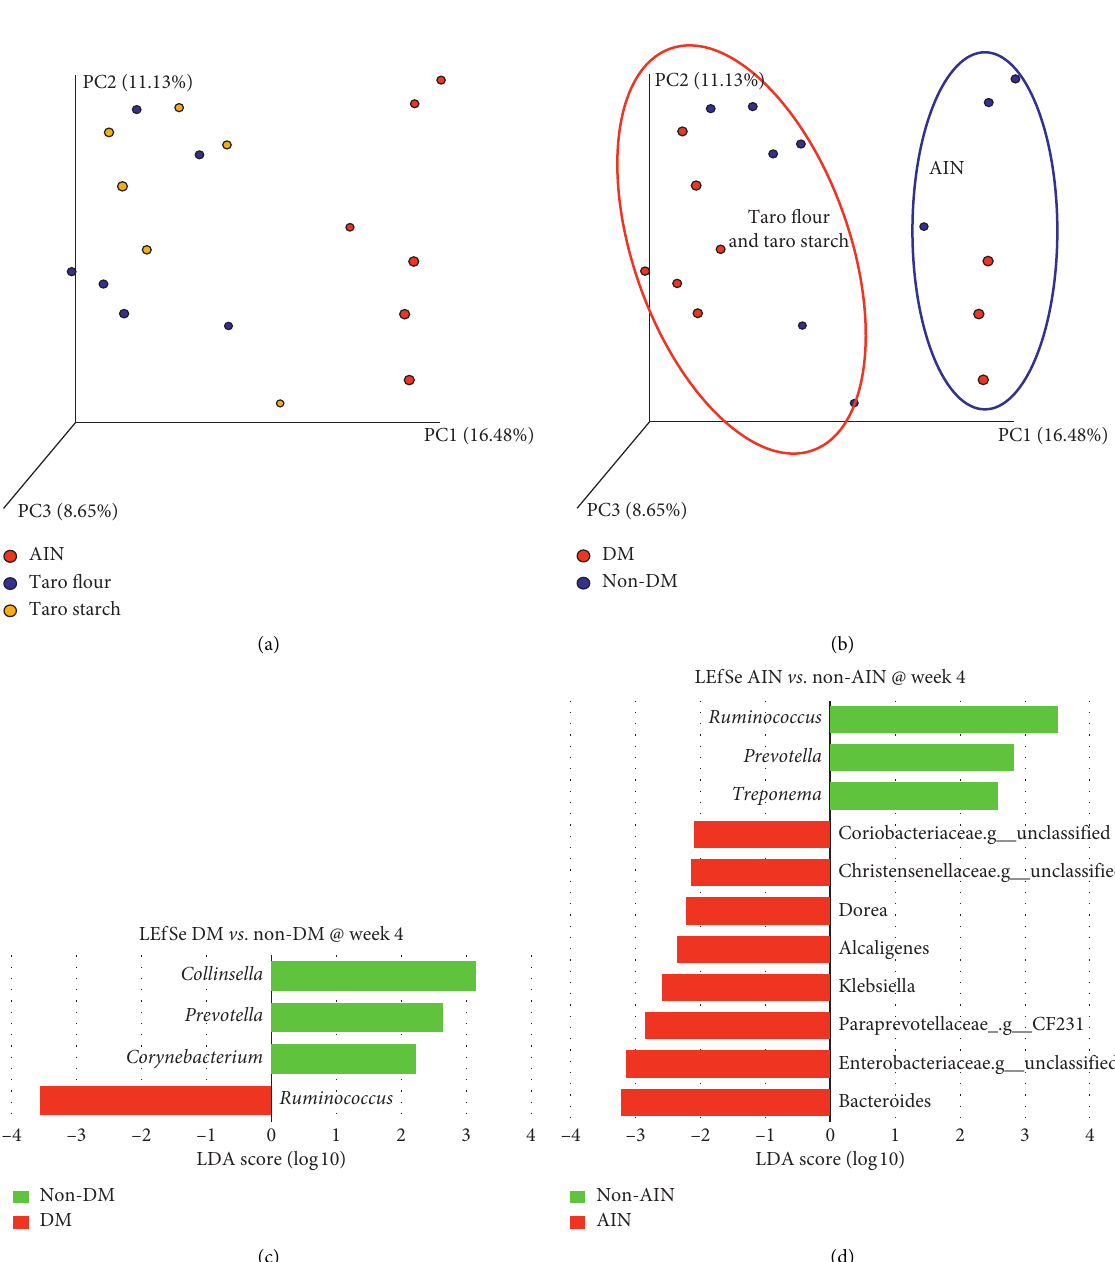
Figure 3: (a, b) β -diversity analysis (unweighted UniFrac) of week 4 microbiota of DM and control (non-DM) rats on the different diets. (a) Labelling of the samples according to diet; (b) labelling of the samples according to DM status. (c, d) Linear discriminant analysis effect size (LEfSe) of AIN- vs. taro-based feeding (c) and DM status (d) at week